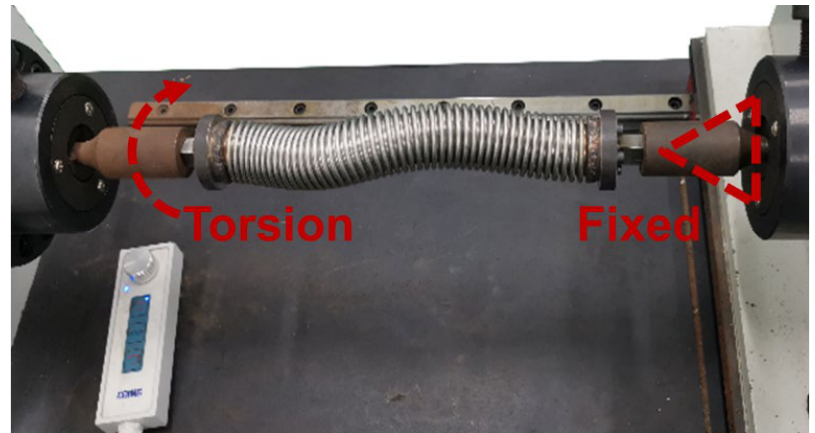
Figure 16. Torsional buckling mode of the bellows through experiment.